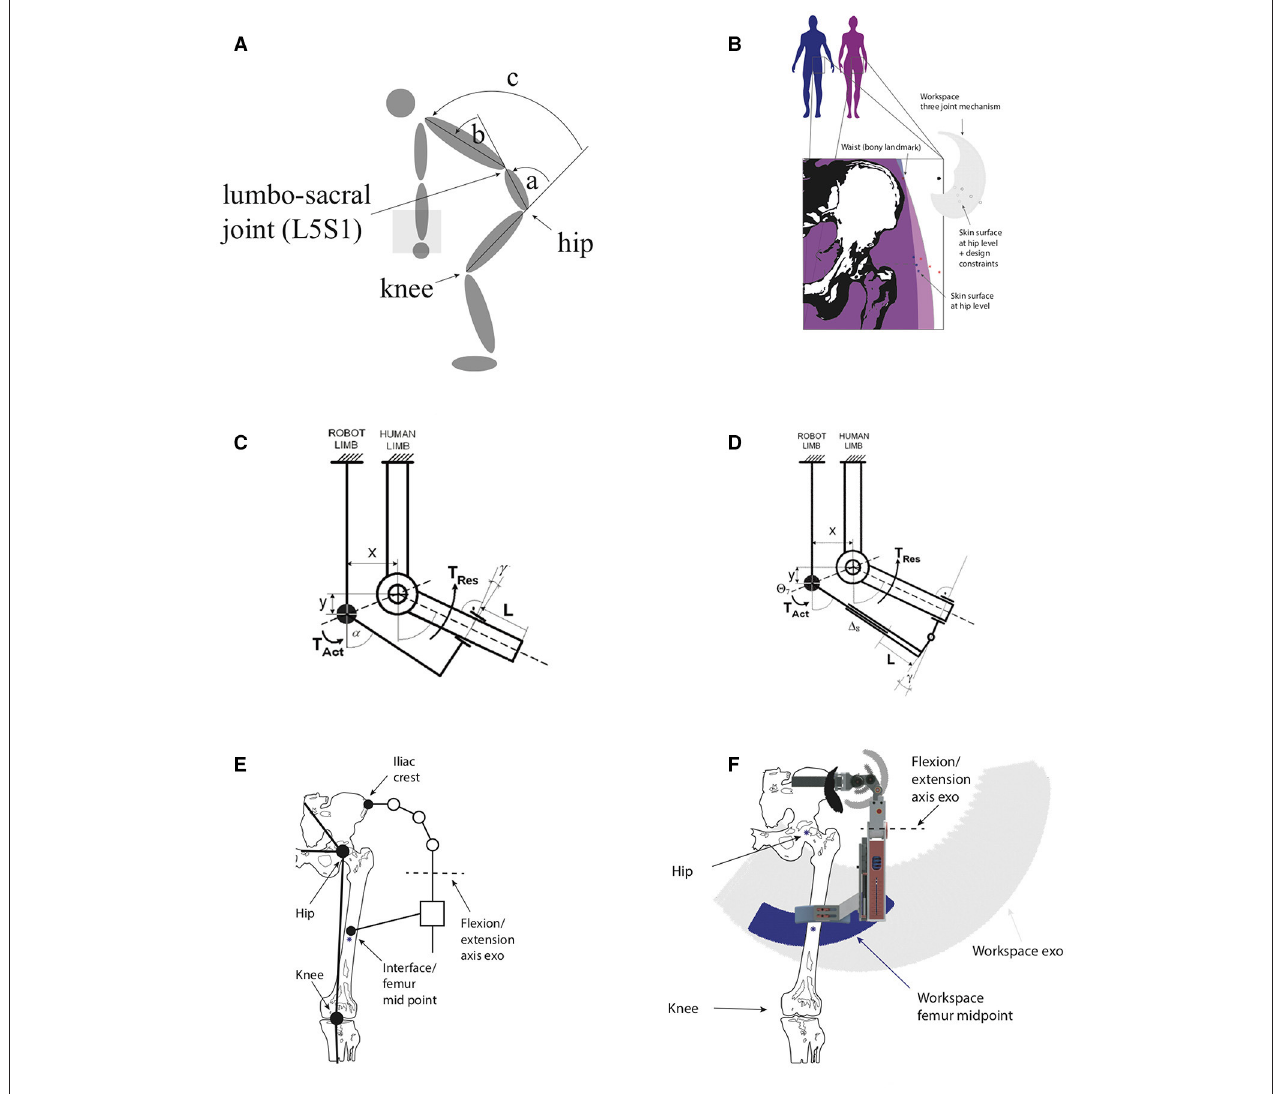
FIGURE 2 | Human angle definitions (A) hip angle (a), lumbar angle (b), and trunk angle (c). Fitting requirements (B) . The relative distance between the waist and the skin surface at hip level differs significantly between man and women and within these groups. Here, the skeleton structure (adopted from Netter, 2011) is scaled to matches the 50 percentile male (blue asterisk middle). The other two blue data points indicate the 5 percentile and 95 percentile male according to Tilley (2002). The red asterisks indicate the same data points for women. Additional design constraints are accommodated by translating these data point; Two structures, that are misaligned (C) : The robot limb and the human limb are horizontally misaligned by a distance x and vertically by a distance y . A torque T Act is applied by the robot limb, displacing it by an angle α . A resulting torque T Res displaces the human limb. The initial misalignment x and y result in a displacement L and a rotation γ of the cuff on human limb. Figure from Schiele and van der Helm (2006); Added degrees of freedom (D) : no more relative motion occurs, because the misalignment is compensated by the slider 1 s and hinge γ . Figure from Schiele and van der Helm (2006); (E) : Exoskeleton together with human skeleton. See Supplementary Materials for detailed model; Workspace comparison (F) : the workspace of the human hip is compared to the exoskeleton workspace in the frontal